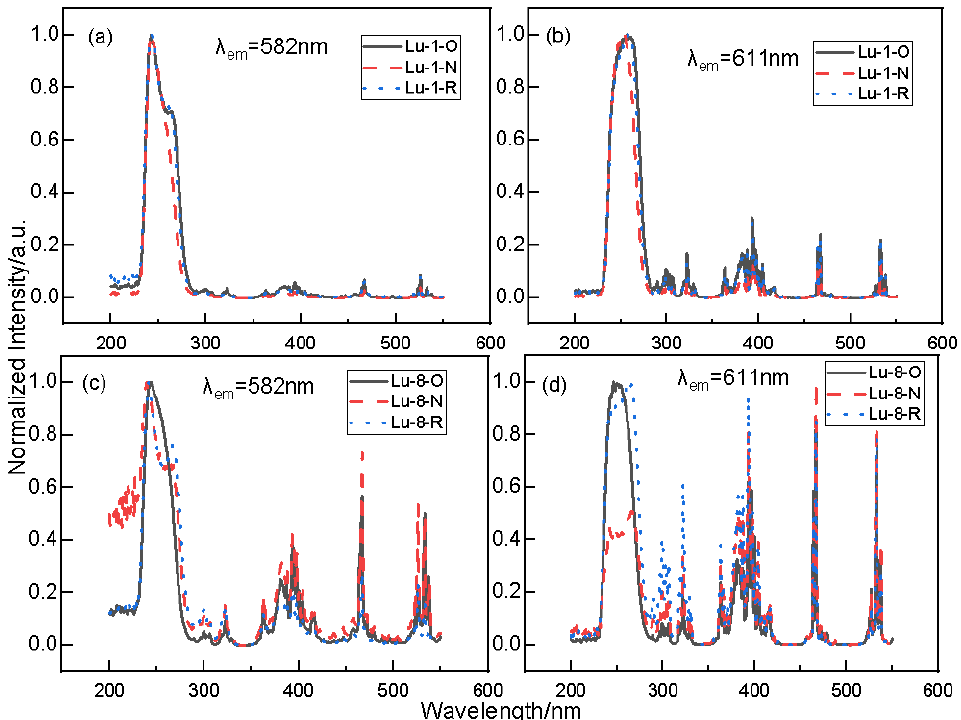
Figure 3. Normalized PLE spectra of Lu 2 O 3 :1%Eu and Lu 2 O 3 :8%Eu single crystals for ( a ) and ( c ) Eu(S 6 ) characteristic emission at 582 nm ( b ), as well as the ( d ) Eu(C 2 ) characteristic emission at 611 nm emission.